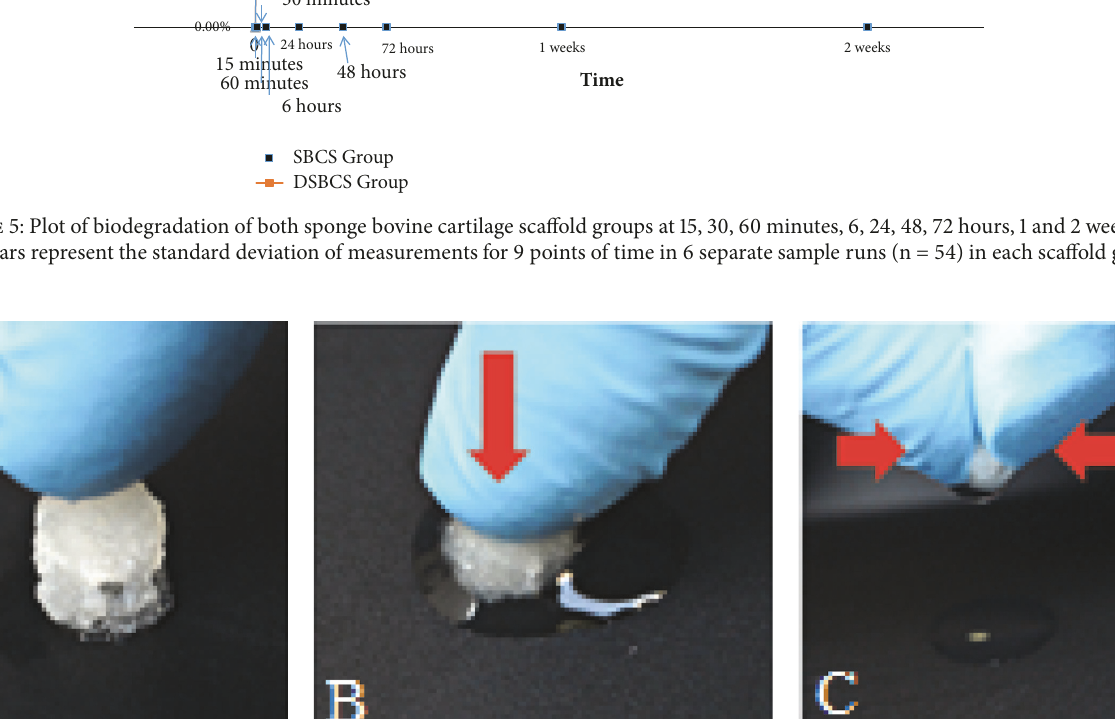
interconnectivity [13]. We found that the mean porosity in SBCS group and DSBCS group was 90.07 ± 4.64% and 88.93 ± 4.18%, respectively. There was no statistical difference between the two groups (p=0.473). High porosity, usually between 80-90%, is enough to help in vitro cell